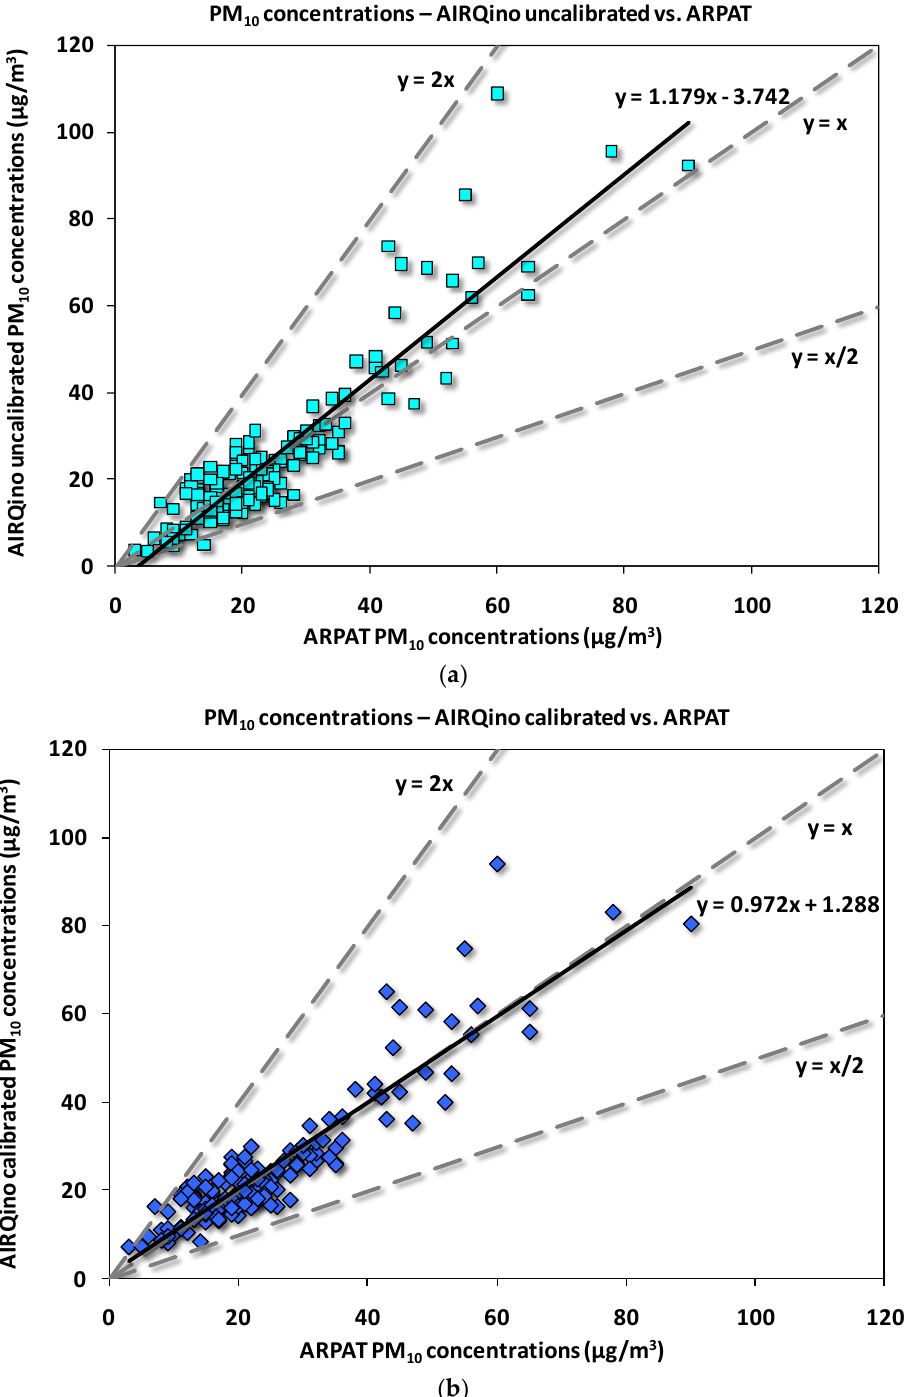
Figure 10. Same as Figure 9, but for PM 10 .